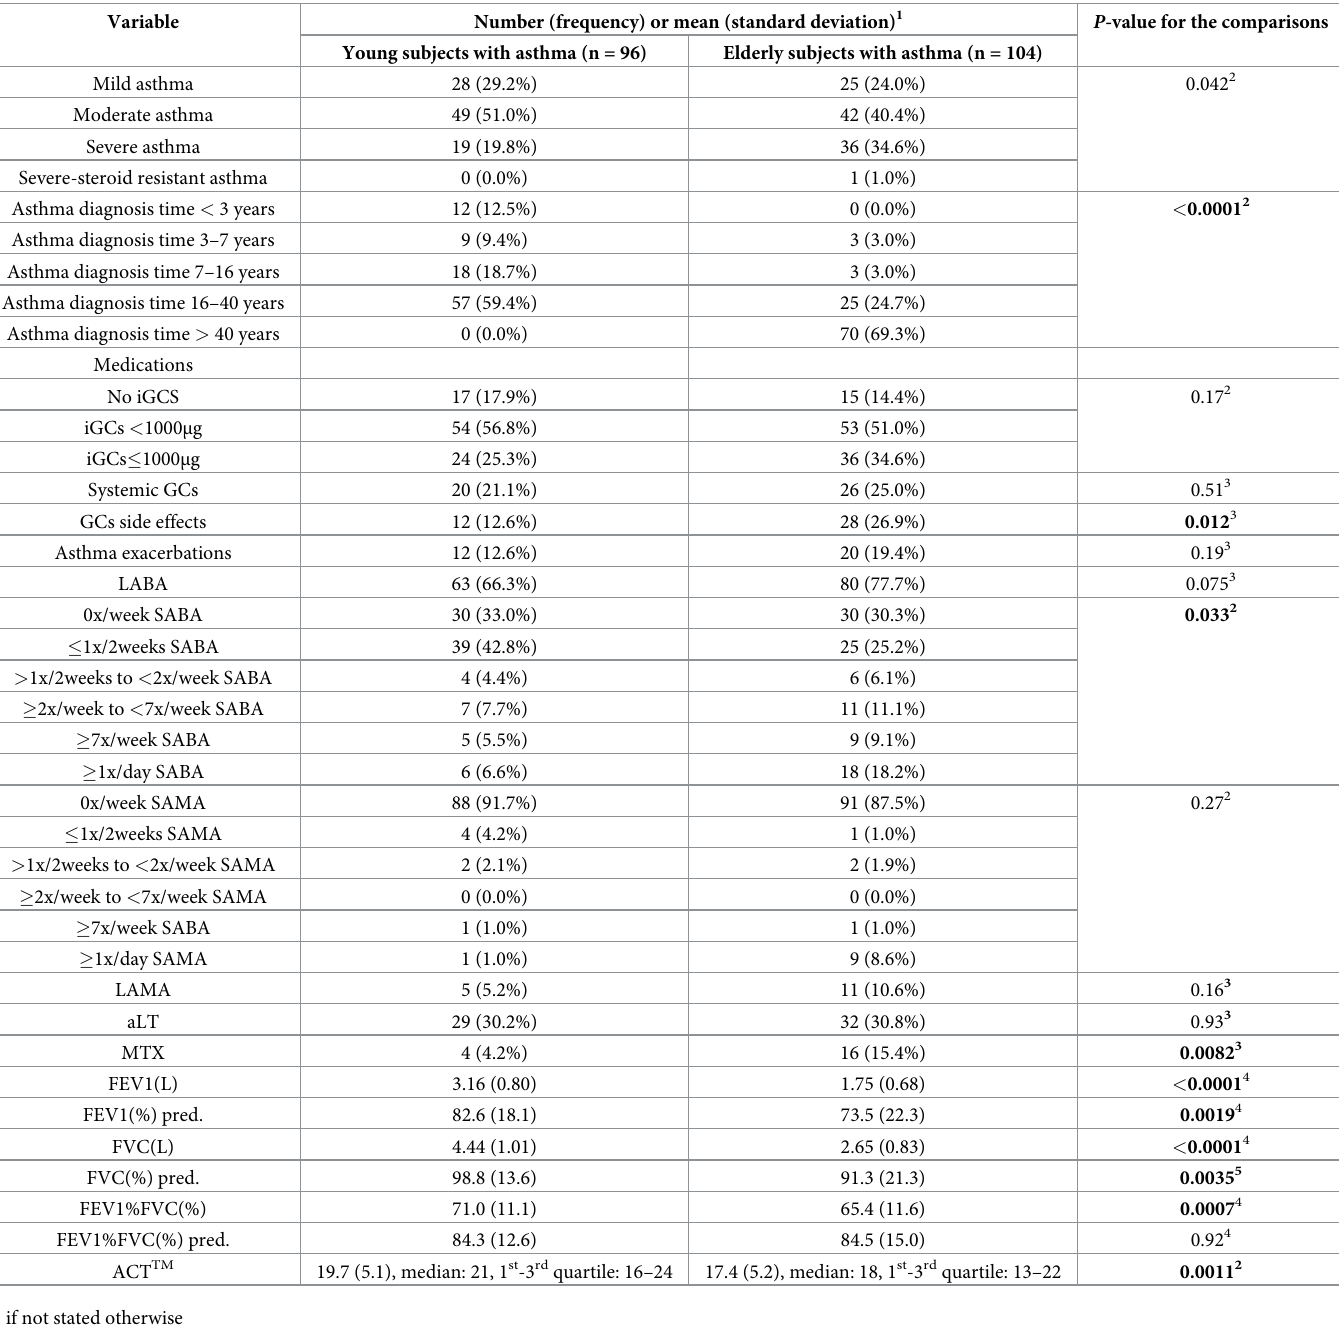
Table 2. Detailed characteristics of asthma severity, levels and frequency of using asthma medications and results of spirometry parameters in young (18–35 years old) and elderly asthmatics (aged � 60